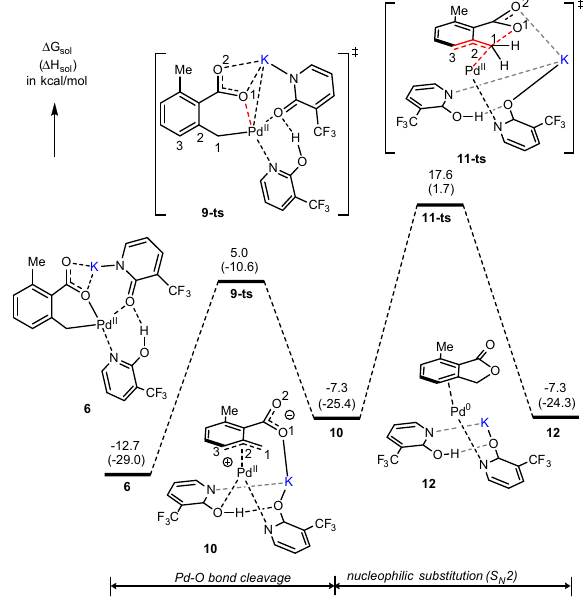
Fig. 3 The calculated free energy pro fi le. Energy pro fi le for the stepwise C – O formation process: Pd – O bond cleavage and nucleophilic